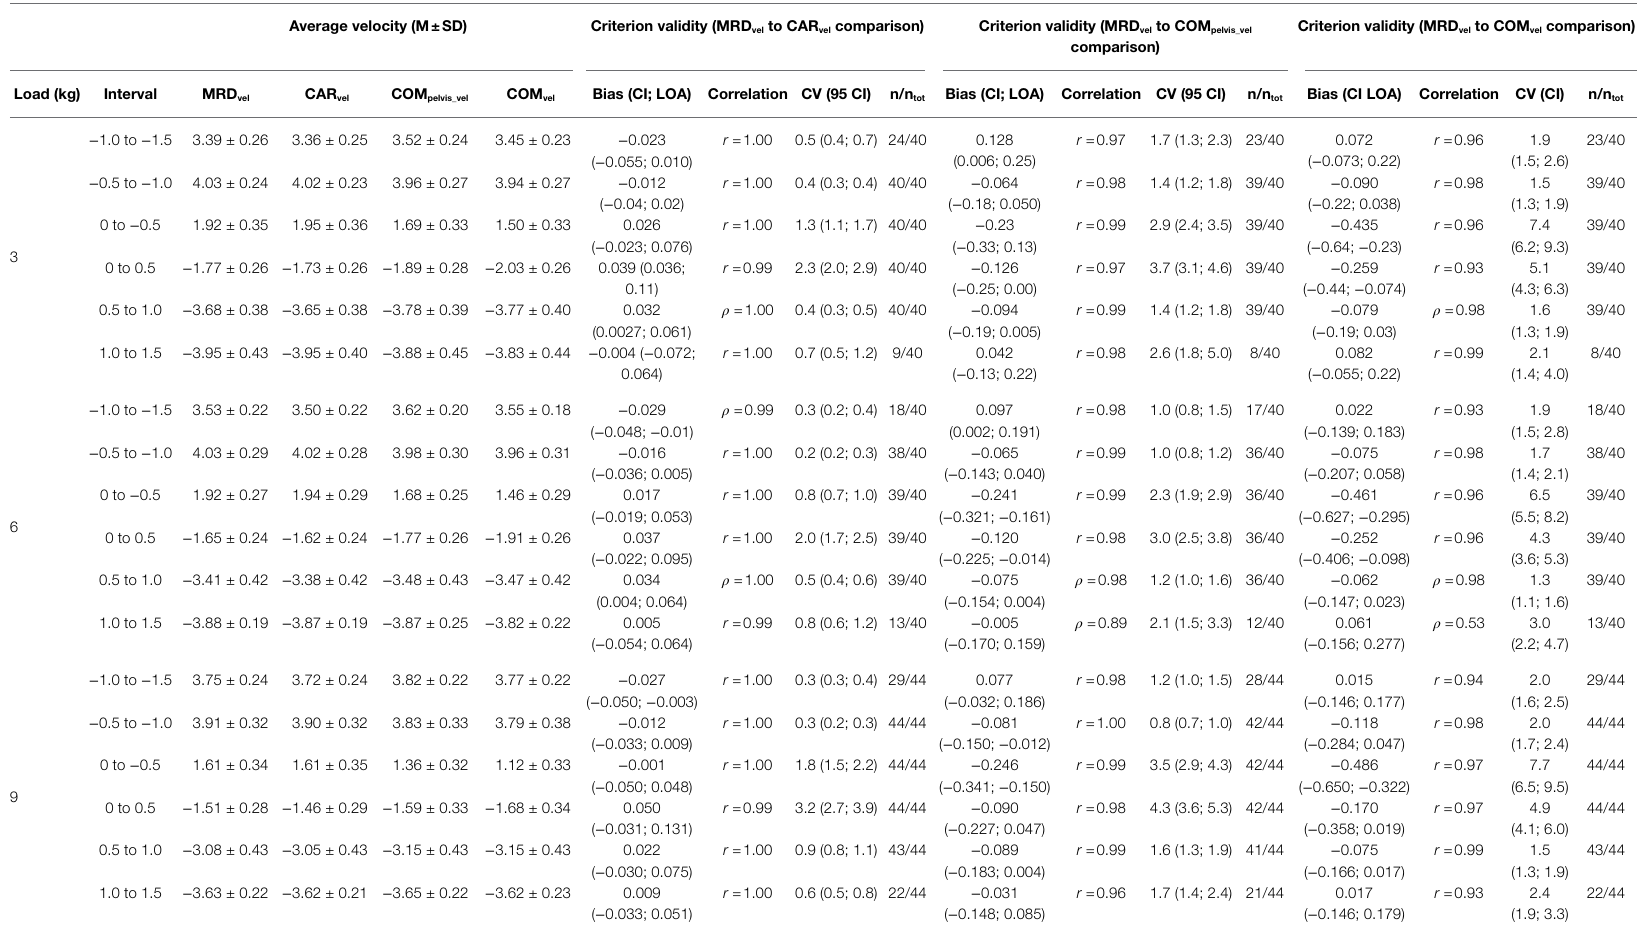
TABLE 2 | Average velocity and criterion validity of a motorized resistance device for different time intervals before ( − ) and after (+) CoD. Average velocity (M ± SD) Criterion validity (MRD vel to CAR vel